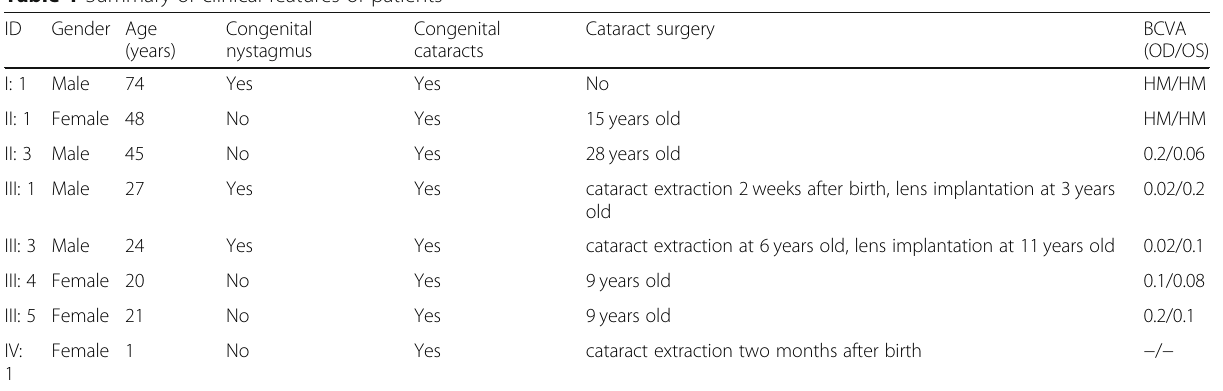
Table 1 Summary of clinical features of